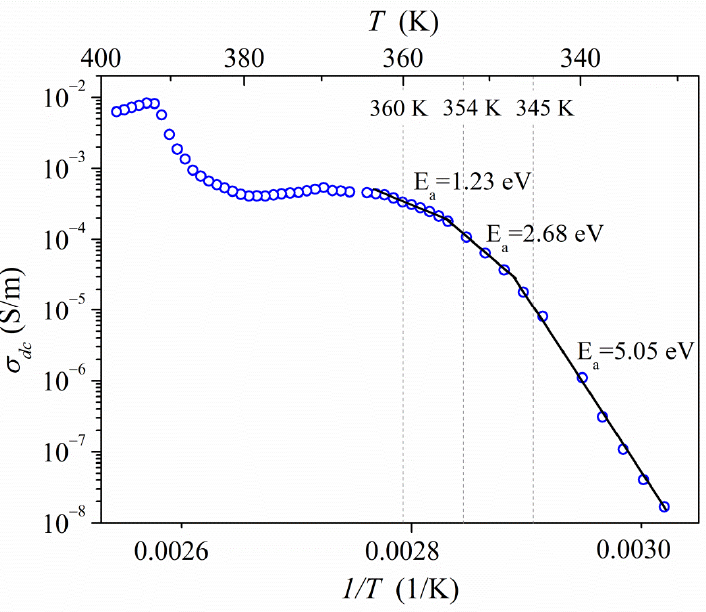
Figure 9. Arrhenius plot of dc conductivity of PyrHem×H 2 O.